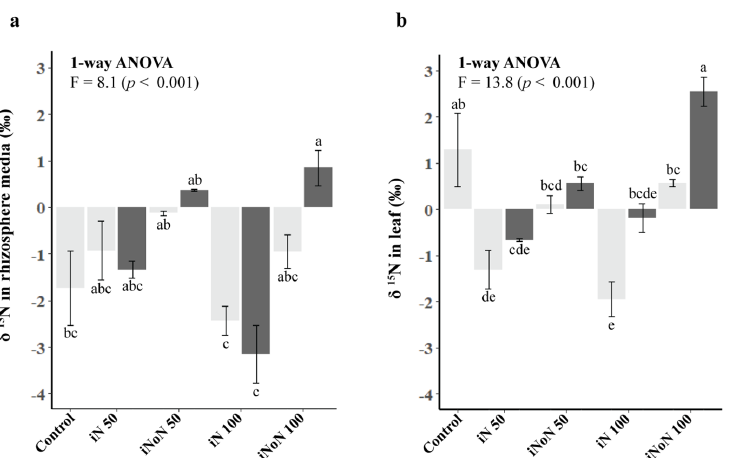
Figure 3. ( a ) Rhizosphere media δ 15 N (‰) and ( b ) leaf δ 15 N (‰) in macadamia seedlings after 28 weeks growing under different fertilizer-N sources (iN, iNoN) without or with PGPR inoculation. Light grey bars represent uninoculated treatments; dark grey bars display treatments inoculated with PGPR. Shown are mean δ 15 N values (±SE, n = 3). Different lower-case letters above means indicate significant differences among treatments (1-way ANOVA and Tukey’s post hoc tests, p < 0.05).